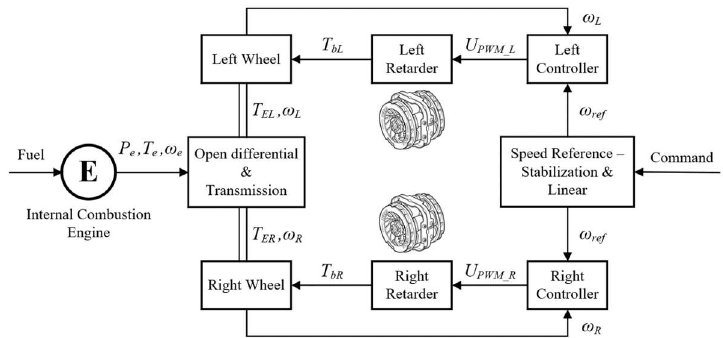
Figure 5. Functional diagram of the stand for measuring the power and torque of an internal combustion